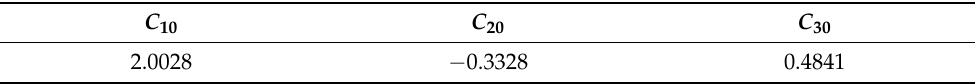
Table 1. The constitutive model parameters of nitrile rubber at room temperature.